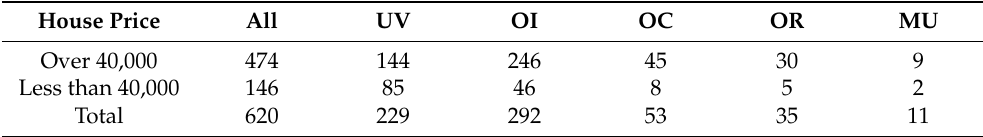
Figure 5. Distribution of UR and house prices: ( a ) all UR projects and ( b ) OC, MU, and OR projects. Table 8. Number of UR projects in different house price ranges.